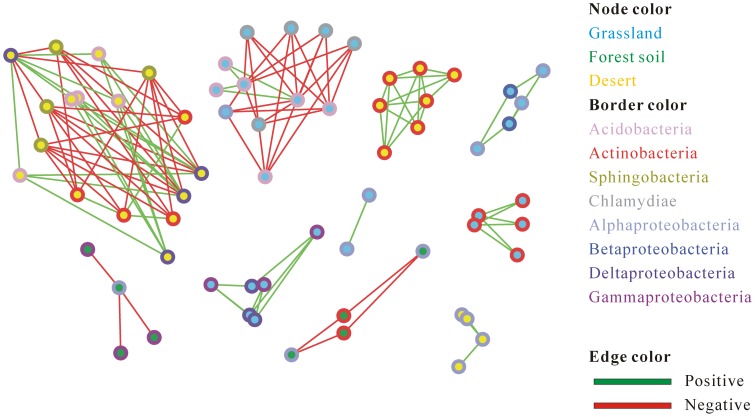
A global microbial interaction network of the soil microbial community.The network captured all significant associations (multiple corrected p-value <0.05) among the abundances of phylotypes at or above the genus level in the soil microbial community within and across the three soil sites. Phylotypes were illustrated by nodes (light blue for grasslands, blue for forest soils, and yellow for deserts) and edges denote significant correlations between phylotypes: positive correlation colored in green means co-occurrence whereas negative correlation in red means mutual exclusion. The border of nodes was colored according to taxonomic affiliations at the class level.